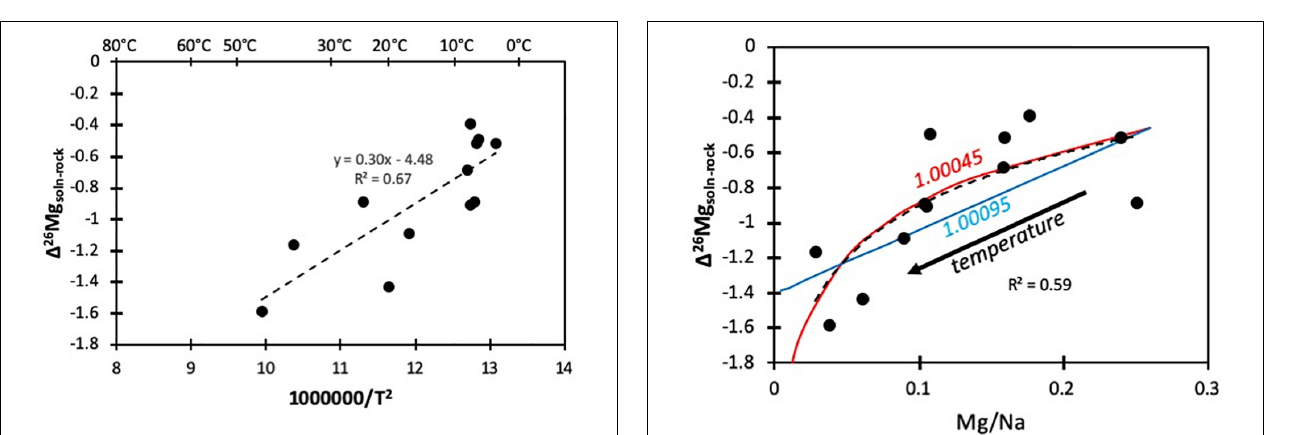
of Mg/Na ratios. The black dotted line represents a best-fit line to the data, while the red line represents the Rayleigh fractionation trend fitted to the best-fit line. The blue line is the best-fit equilibrium fractionation line. The italicized numbers represent the required α values.